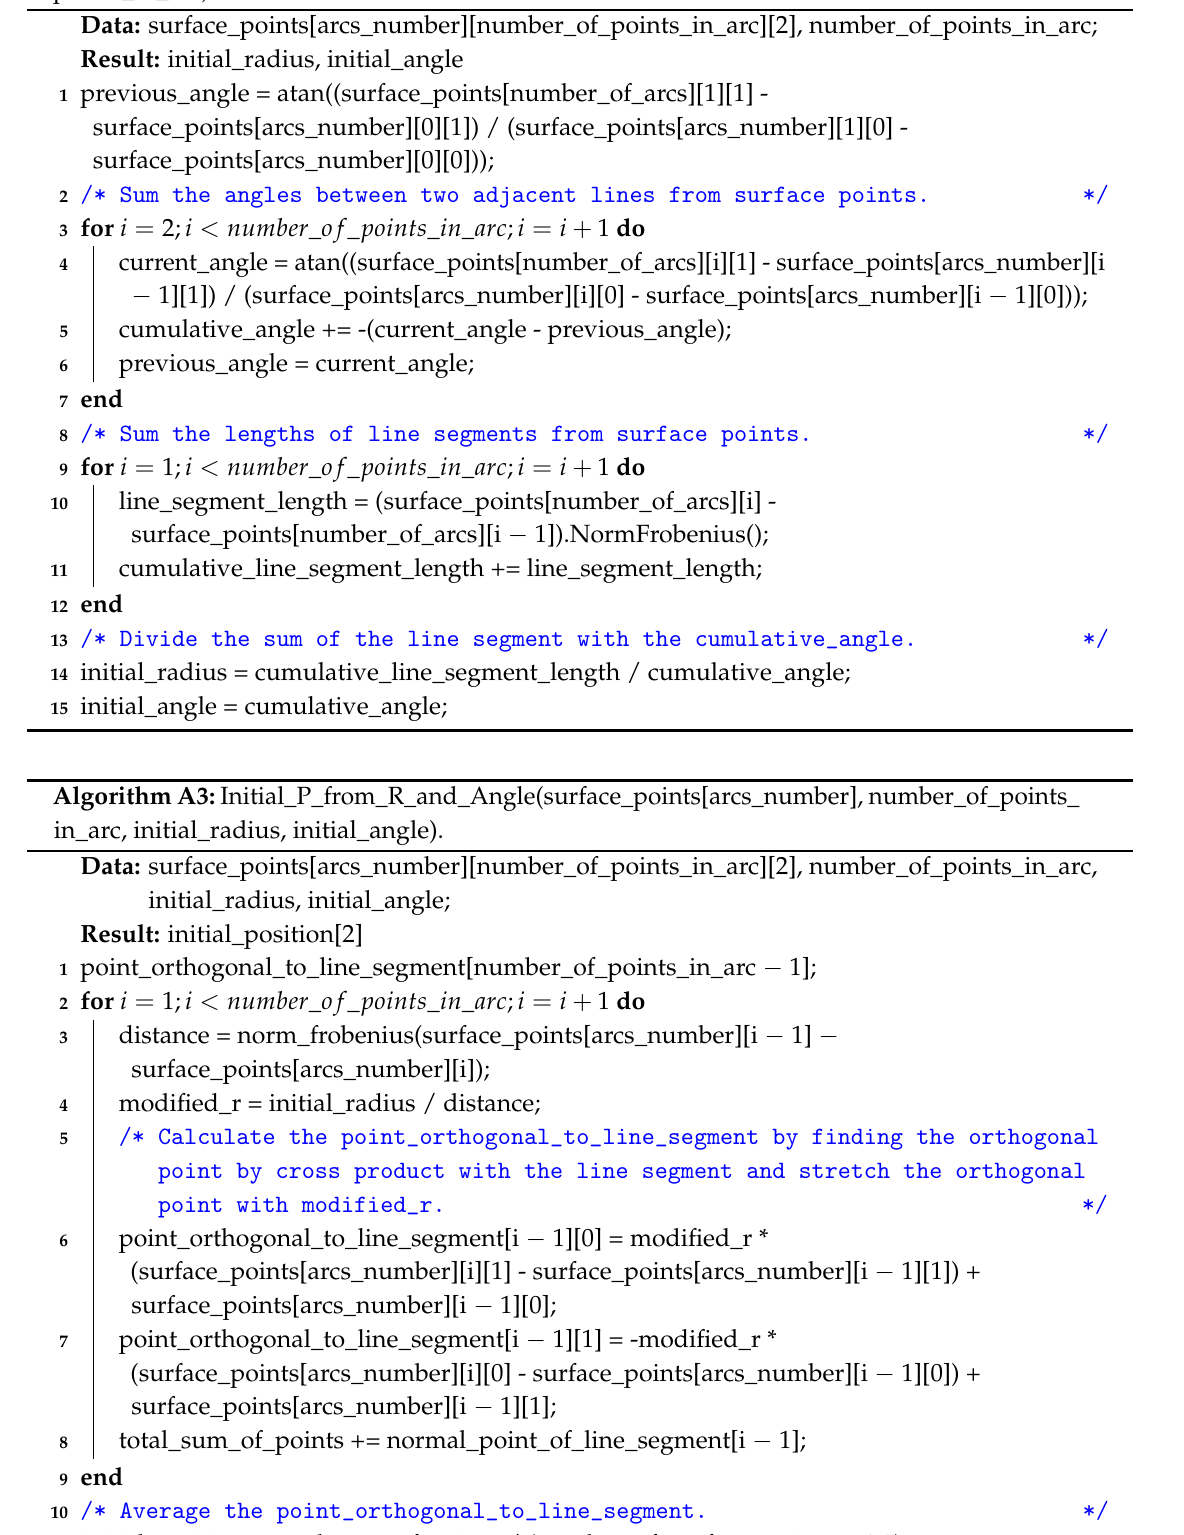
Algorithm A2: Initilal_R_and_Angle_from_Points(surface_points[number_of_arcs], number_of_